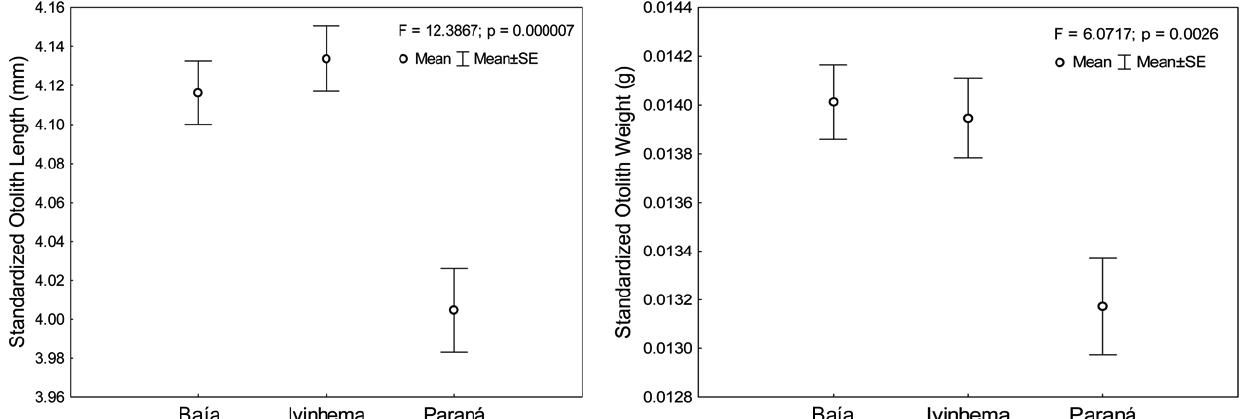
Fig. 5. Analysis of variance between the length and weight of otolith of Prochilodus lineatus in the three rivers sampled (Baía, Ivinhema and Paraná).